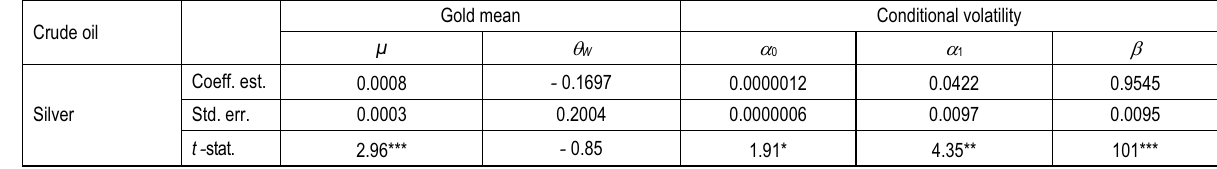
Table 9 (cont.). Estimation results for